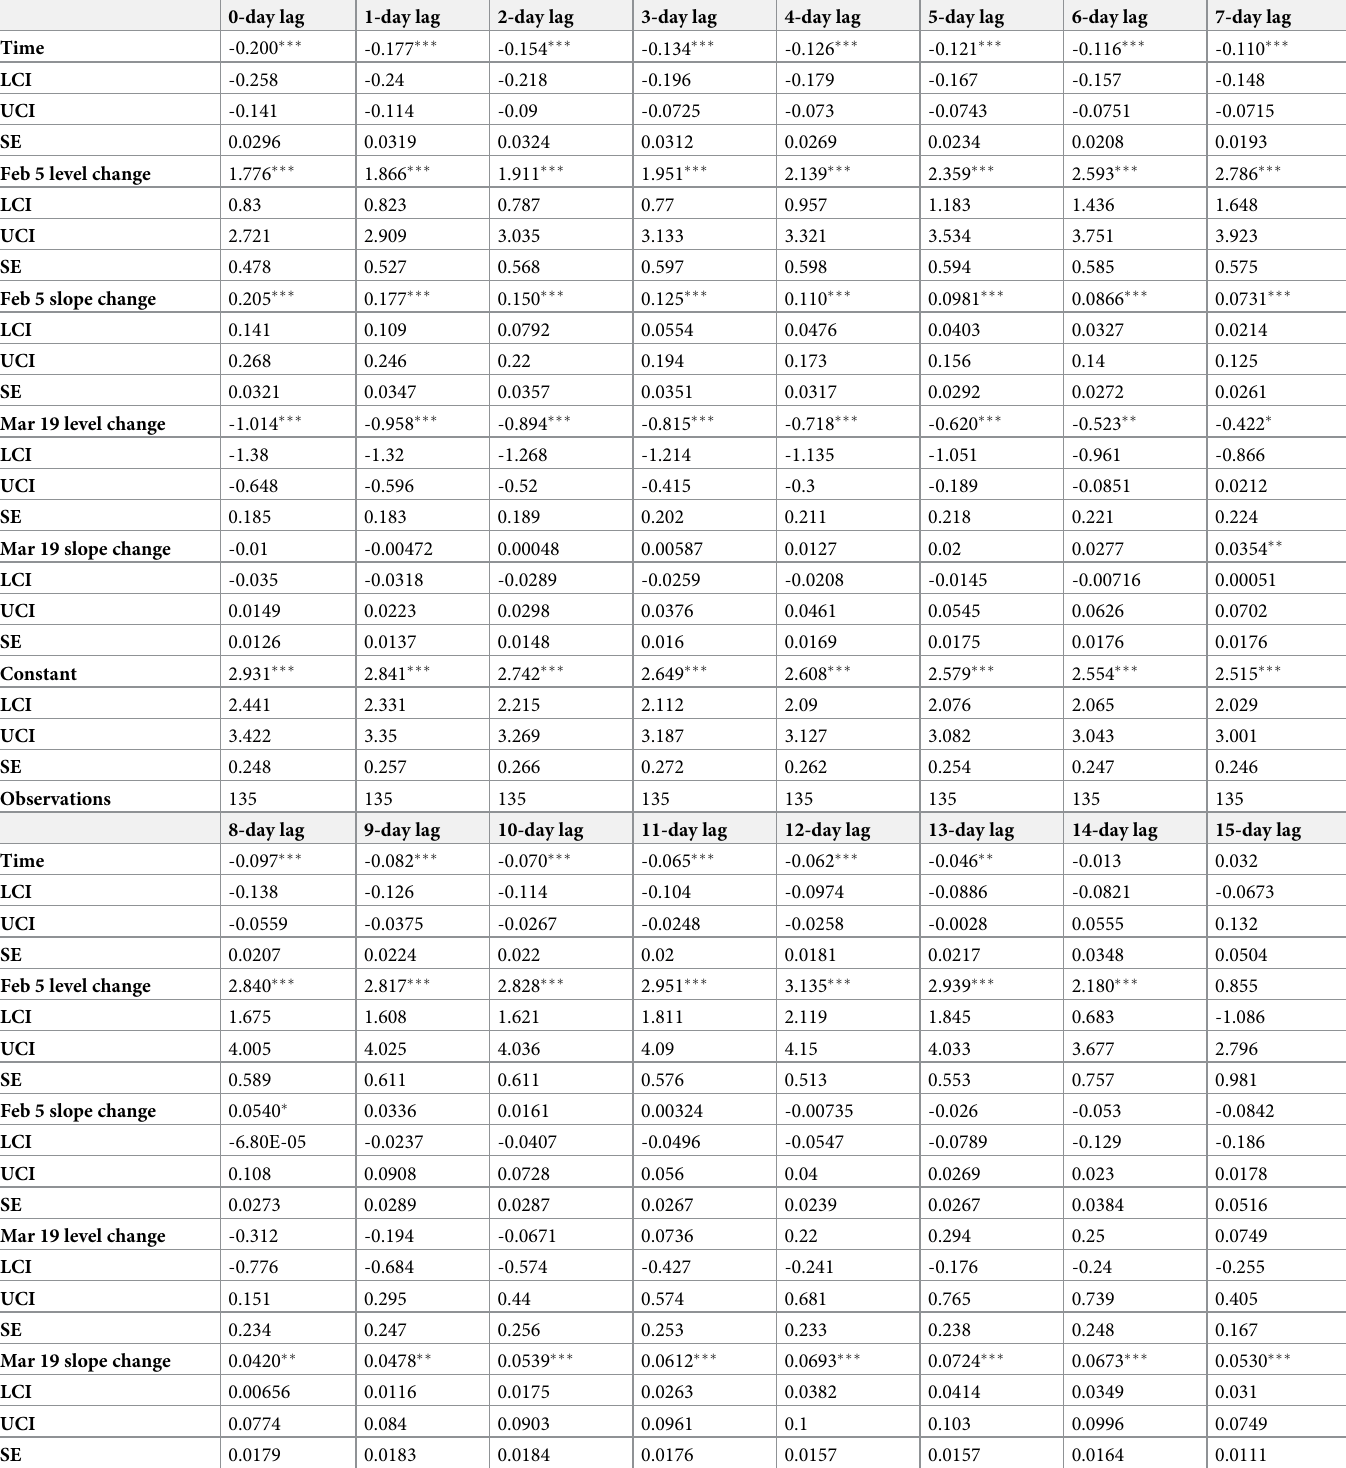
Table 1. Global interrupted time-series results. Analyses with two intervention points on February 5, 2020 and March 19, 2020, with lags from 0–15 days. Coefficients, lower 95% confidence interval (LCI), upper 95% confidence interval (UCI), and standard errors (SE) are provided for the underlying time trend, two slope and level changes, and a constant. Analyses exclude